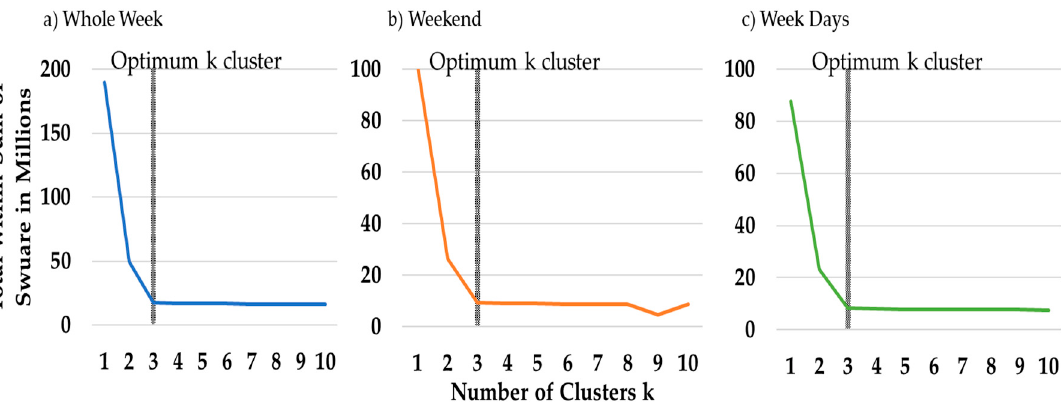
Energies 2018 , 11 , x